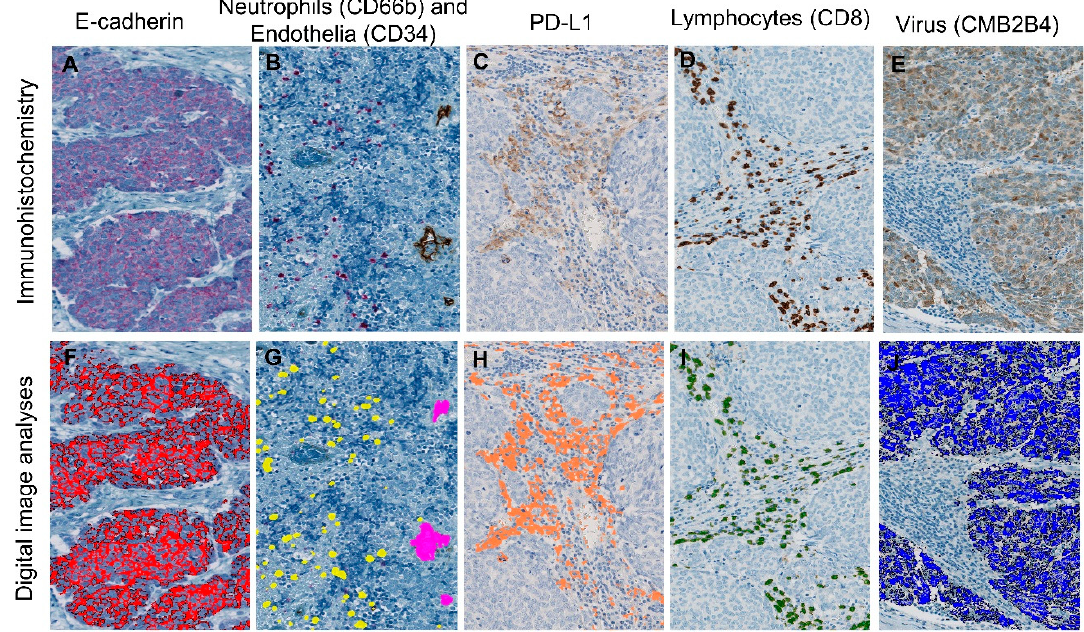
Figure 1. Sections stained with immunohistochemistry (IHC) (top row) analyzed with digital pathology (bottom row). Stained IHC sections of ( A ) E-cadherin, ( B ) CD66b neutrophils & CD34 endothelia, ( C ) PD-L1, ( D ) CD8 lymphocytes and ( E ) CMB2B4 at 20 × magnification with comparable illustrations of digital image analysis ( F – J ). ( B ) CD34 endothelia (brown) and CD66b neutrophils (red) are stained on the same section. The digital image analysis software converts the IHC dye into a digital color